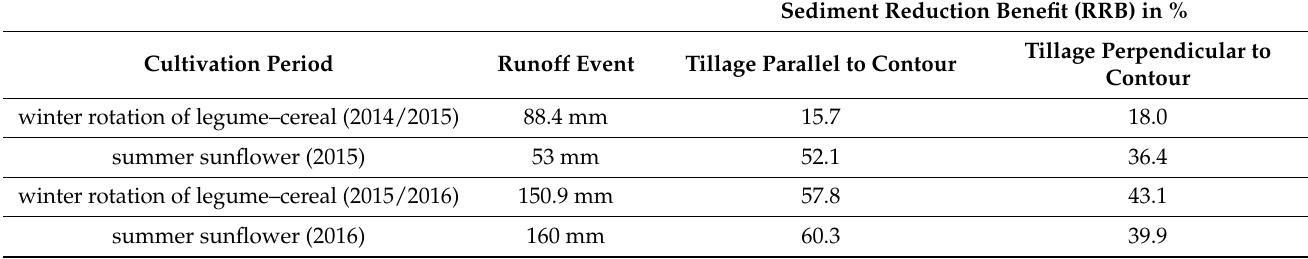
Table 6. Sediment reduction benefit (SRB) for the four cultivation